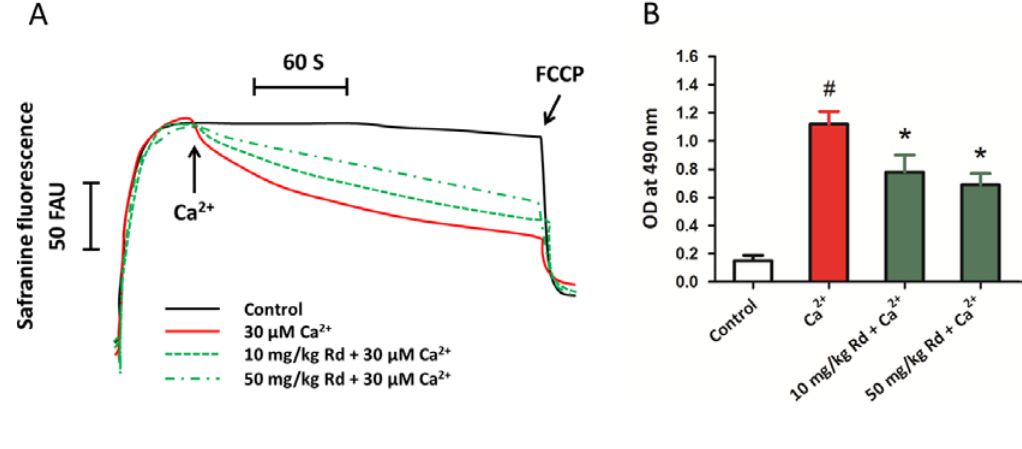
Figure 7. Protective activity of Rd against mitochondrial permeability transition and cytochrome c release through in vivo administration. Rats were pretreated with Rd at the concentrations of 10 or 50 mg/kg for 7 days before the spinal cord mitochondria were isolated, and then the isolated spinal cord mitochondria (0.5 mg protein/mL supported by succinate) were incubated with 30 μM Ca 2+ . The mitochondrial membrane potential was measured up to 300 s ( A ); and the cytochrome c release induced by Ca 2+ was detected ( B ). The data were represented as means ± SD from five experiments. Traces are representative of three independent experiments performed in duplicate and were expressed as fluorescence arbitrary units (FAU). # p < 0.05 vs. control. * p < 0.05 vs. Ca 2+